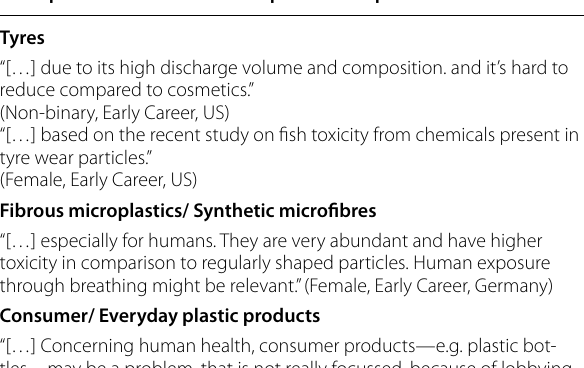
Table 5 Open-ended answers selected to illustrate responses to “In your opinion, is there a particular microplastics source which has the most impact on the natural environment and human health?